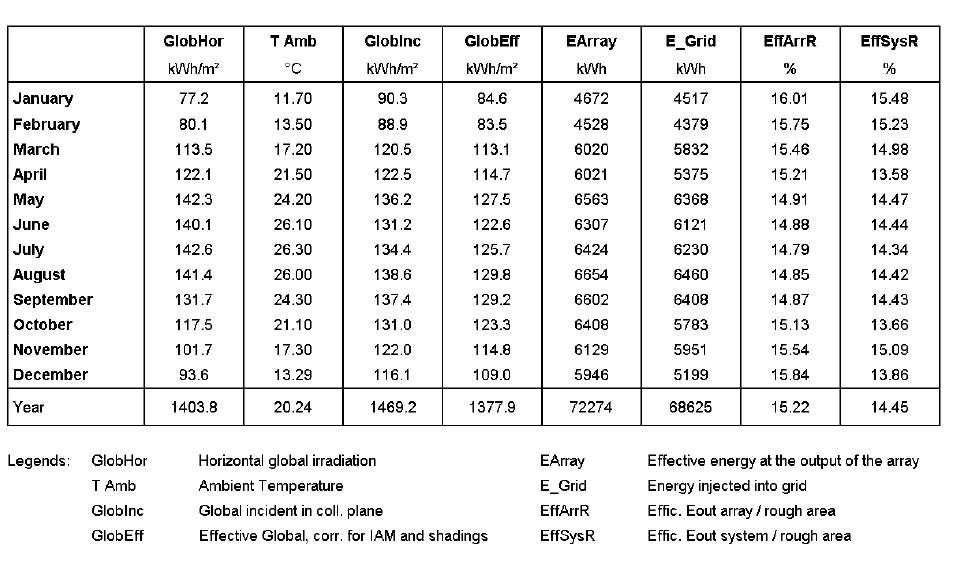
Figure 11. Total annual average electricity from the solar power